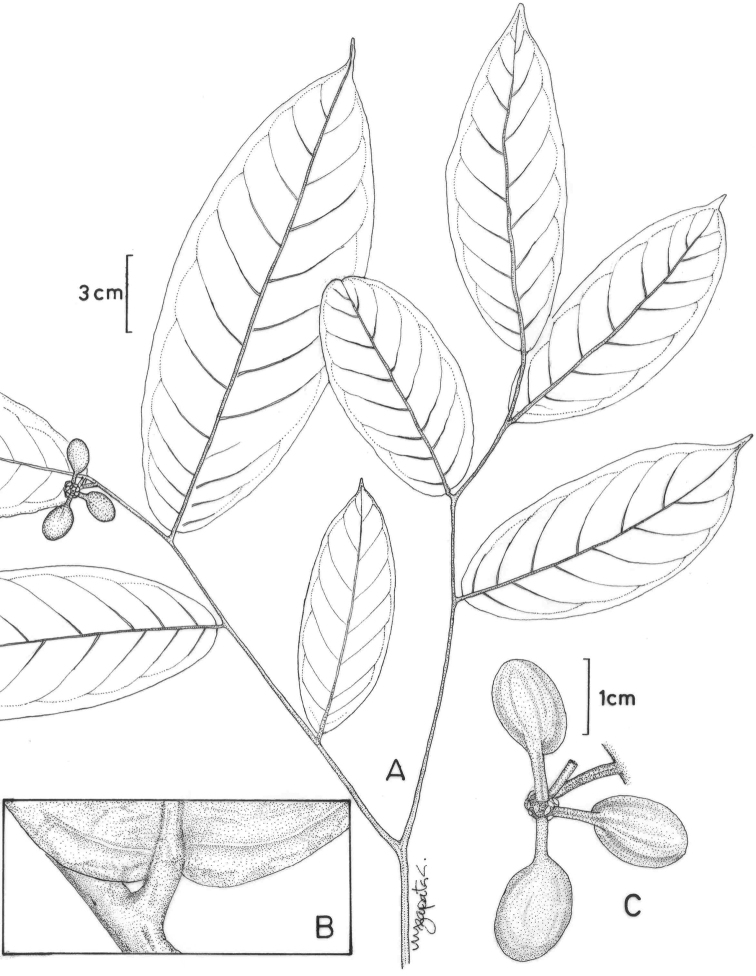
Cremastospermacenepense Pirie & Zapata. a fruiting twig b leaf base c fruit (a, cRojas 269; bKayap 1078).